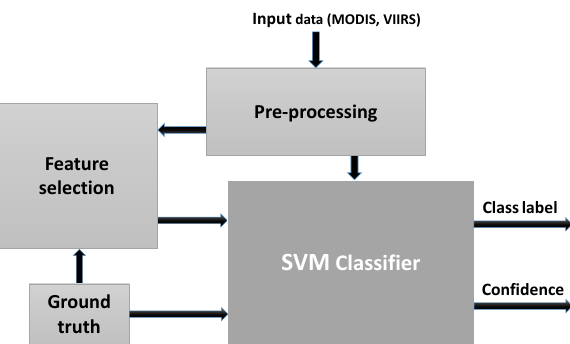
Figure 9. Block diagram of the proposed lake ice detection approach using satellite data.